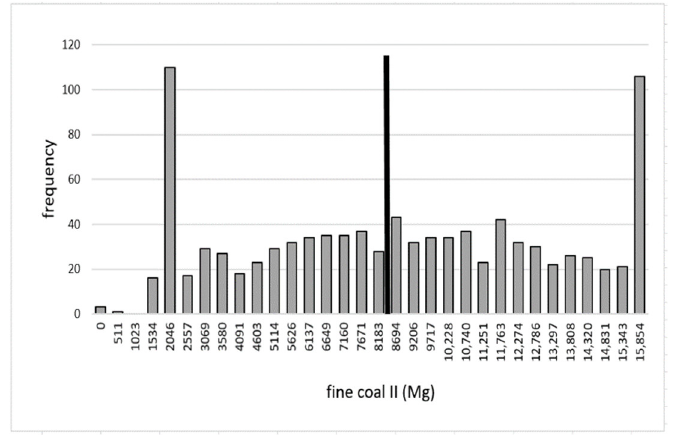
Figure A8. Histogram showing frequencies of achieving given quantity of sales of fine coal II for mine “D” with σ yprog .